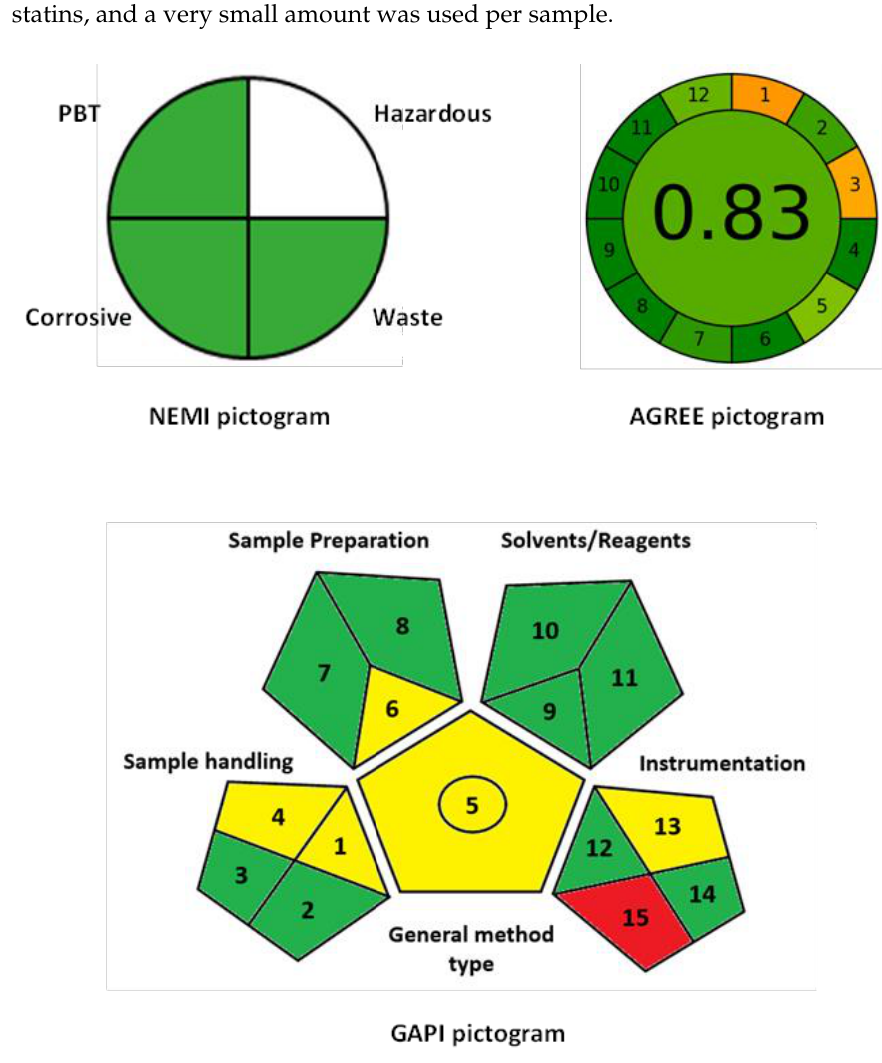
Figure 8. Results of NEMI, AGREE and GAPI metric tools for evaluation of the greenness of the proposed MW-SFA for statins.